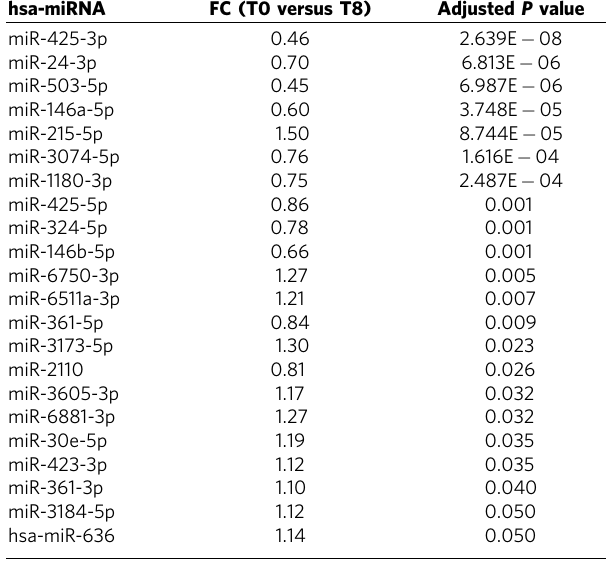
Table 1 | Duloxetine responders. hsa-miRNA